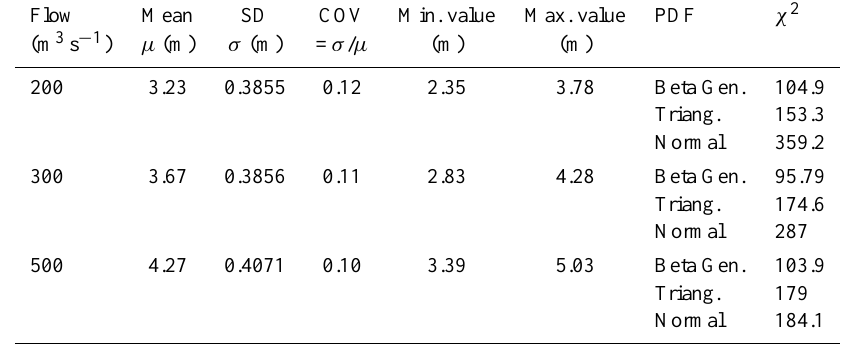
Table 2. Uniform flow model. Adaptation of PDFs to water depth with uniform distributions for n i (1000 simulations). Flow Mean Min.